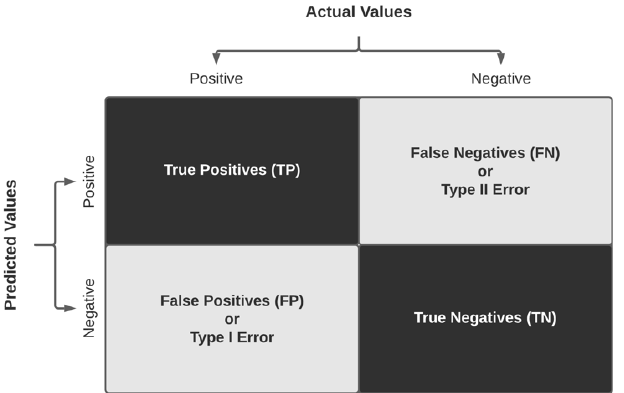
Figure 10. Visualization of a generic confusion matrix.